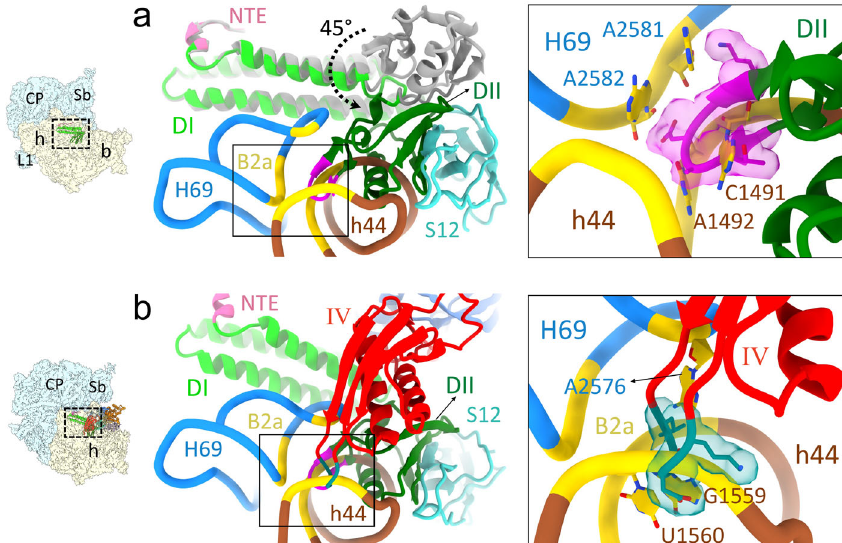
Fig. 3 Direct involvement of RRF mt domain II and EF-G1 mt domain IV in human mitoribosome recycling. a Comparison of the overall conformation of RRF mt between the Class I (gray) and Class III (green) complexes revealed that domain II rotates by about 45° towards the 28S subunit. Such a rotation would sterically clash with the 12S rRNA helix 44 (h44, brown) and MRP uS12m (cyan) and destabilize a crucial inter-subunit bridge, B2a (yellow). Inset shows the magni fi ed view of the inter-subunit bridge B2a with RRF mt domain II residues V121-K127 (shown with density in magenta) disrupting B2a by inserting between h44 residues (C1491 and A1492) and H69 residues (A2581 and A2582). b Superimposition of the Class III complex with the Class I complex shows a direct overlap between the loop1 region (dark cyan) of EF-G2 mt domain IV (red) and the intersubunit bridge B2a (yellow) formed between h44 (brown) and H69 (blue). Inset shows the magni fi ed view of EF-G2 mt domain IV residues L582-R585 (shown with density in dark cyan) that will disrupt the bridge B2a by inserting between h44 residues (G1559 and U1560) and H69 residue (A2576) and pushing the 28S subunit (h44) away. Thumbnails to the left depict an overall orientation of the 55S mitoribosome, with semitransparent 28S (yellow) and 39S (blue) subunits, and overlaid position RRF mt . Landmarks on the thumbnails are same as in Fig.